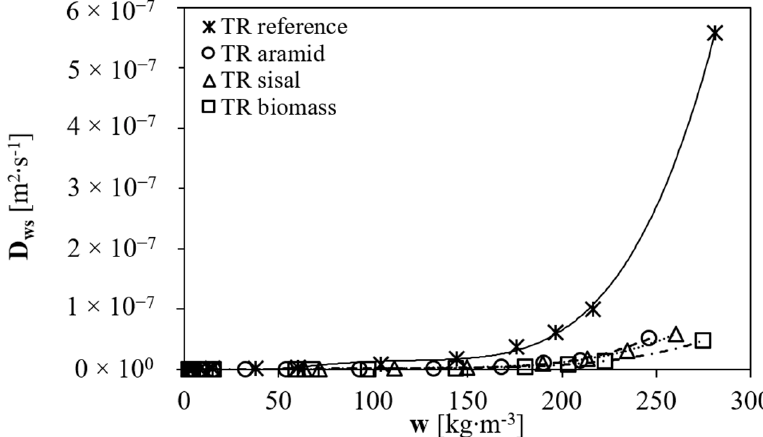
Figure 6. Liquid transport coefficient for suction ( D ws ), as a function of moisture content ( w